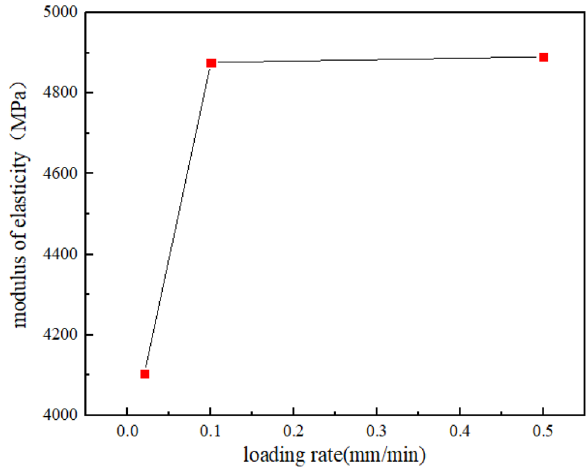
Figure 7. The relationship between modulus of elasticity and loading rate.